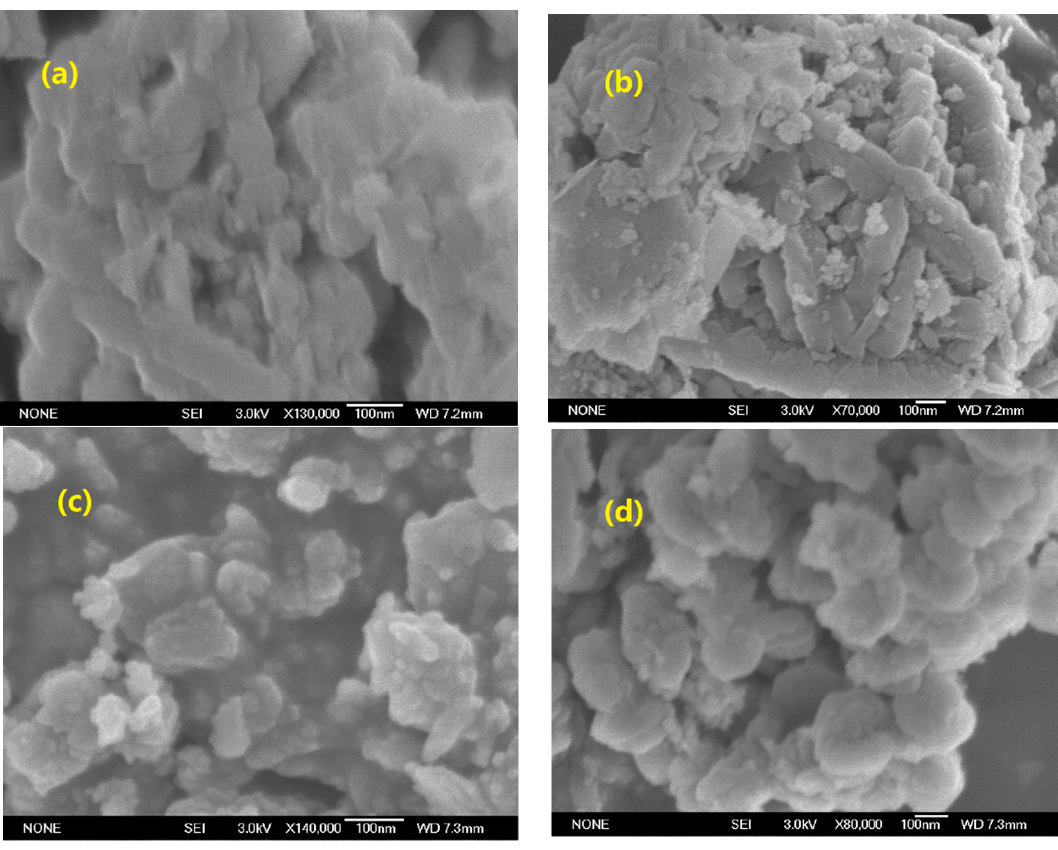
Figure 3. SEM images: ( a ) RM, ( b ) WRM1, ( c ) ARM and ( d ) ARM(400).